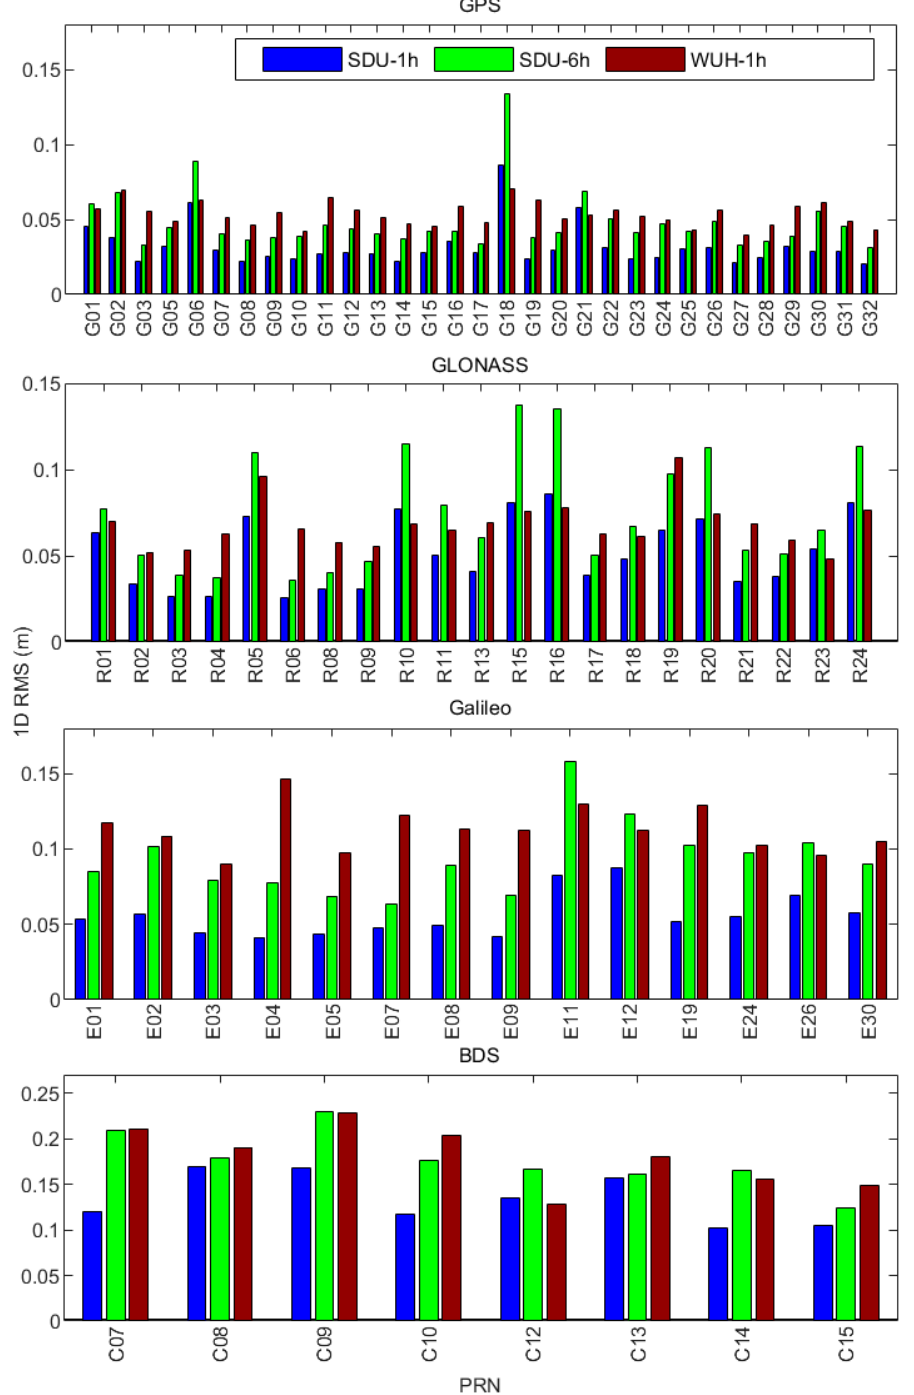
Figure 12. RMS of predicted orbit of each satellite from GPS, GLONASS, Galileo and BDS (from top to bottom) using SDU-1h, SDU-6h and WUH-1h strategy.